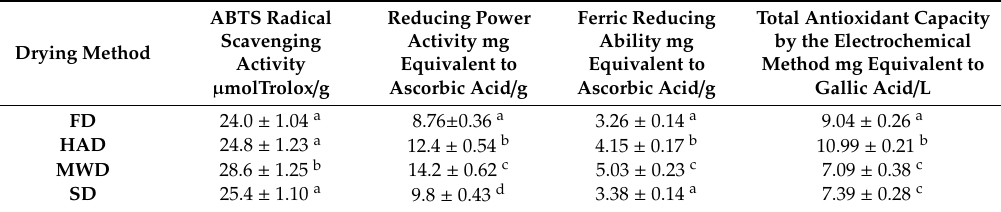
Table 5. ABTS radical scavenging activity, reducing power activity and ferric reducing ability (the FRAP assay) of dry fruit bodies Pleurotus ostreatus after in vitro digestion (M ±